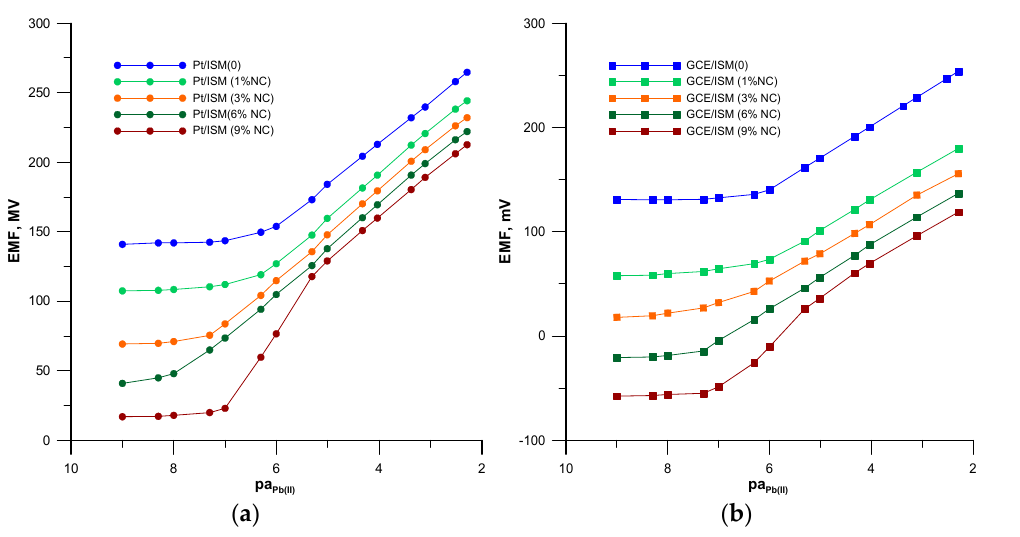
Figure 3. Calibration curves of the studied ISEs: ( a ) based on Pt electrode and ( b ) based on GC electrode.